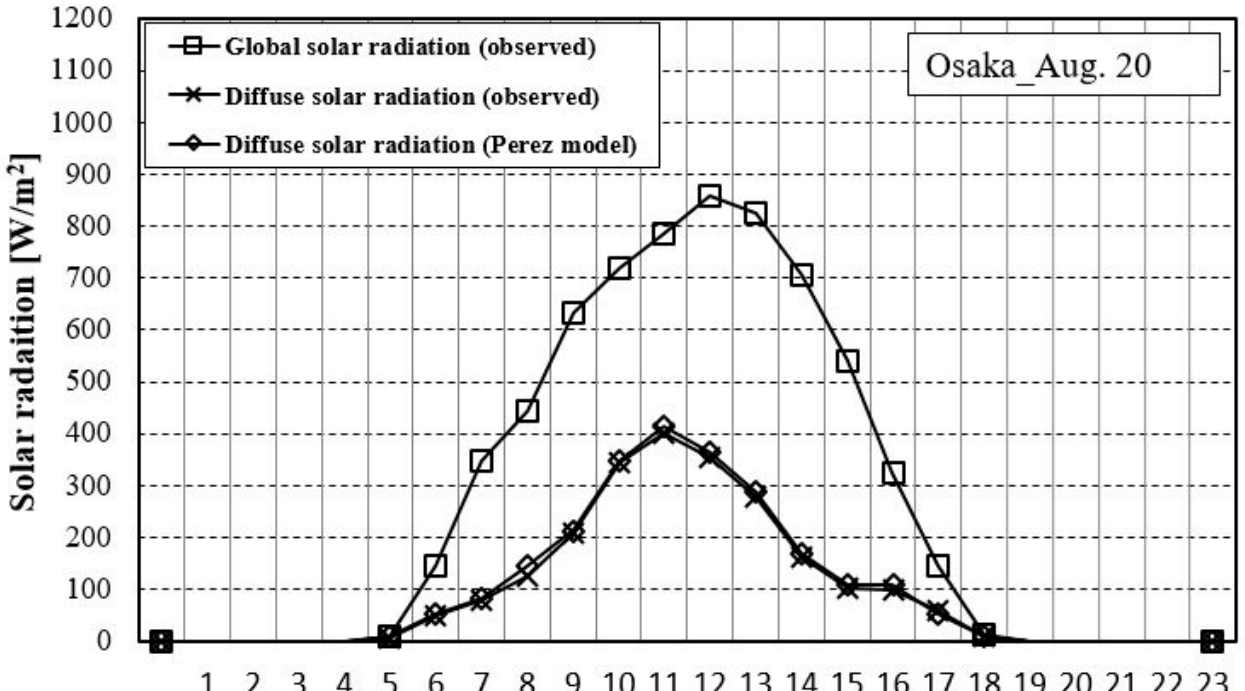
Figure 8. Observed diffuse solar radiation and diffuse solar radiation separated by the Perez model on a representative day (20 August) in Osaka, Japan.